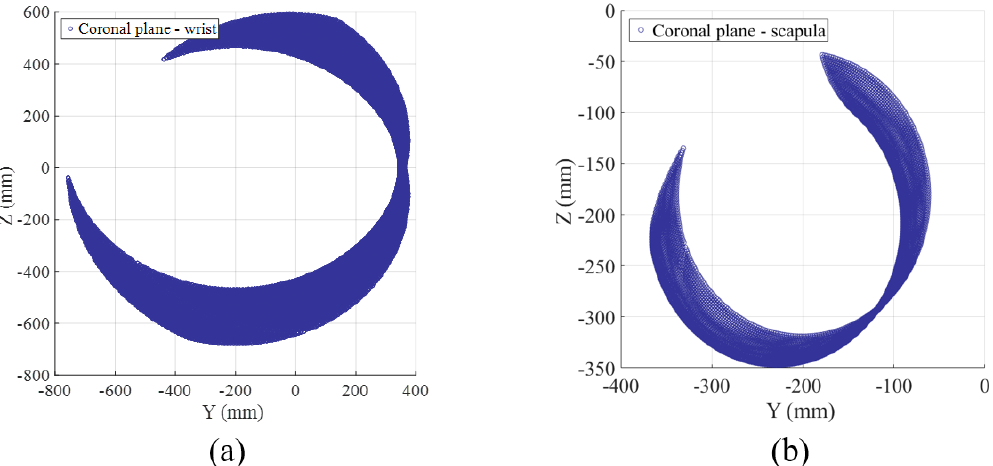
Figure 9. The motion space in the coronal plane. (a) The motion space of the wrist in the horizontal plane. (b) The motion space of the scapula in the horizontal